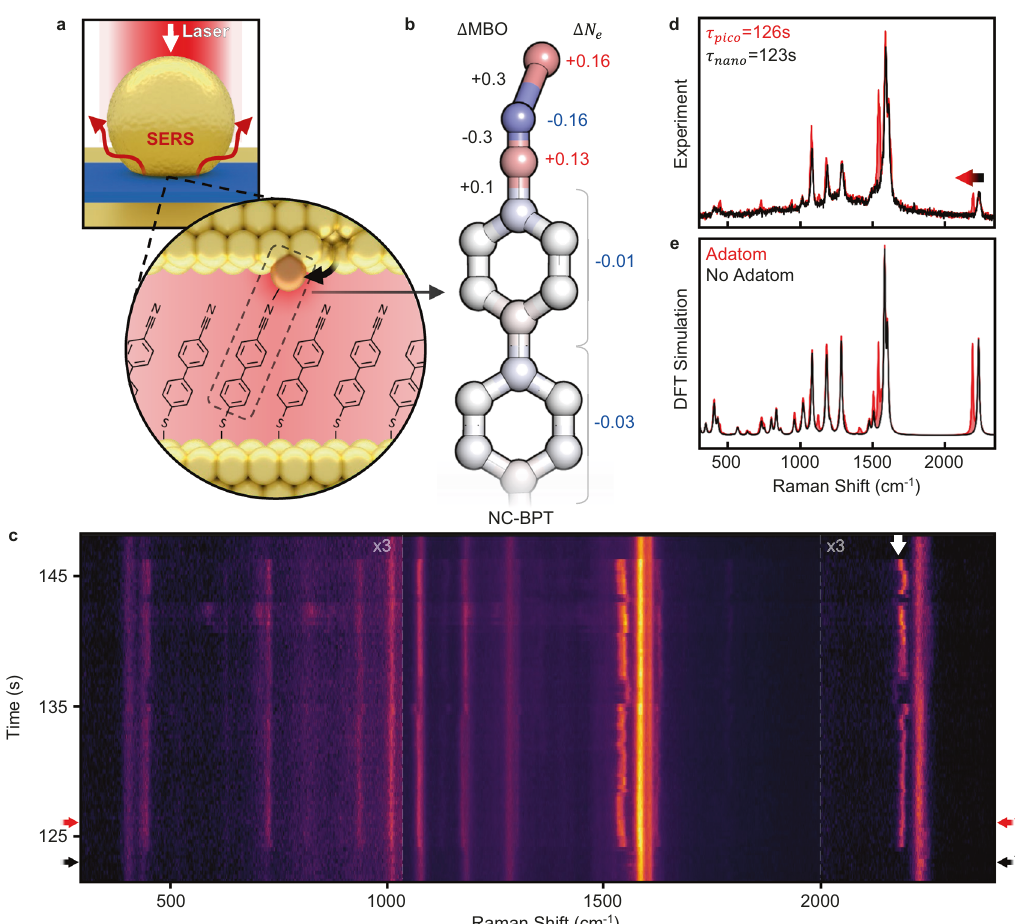
Fig. 1 Picocavity formation focuses light onto a single molecule. a Nanoparticle-on-mirror (NPoM) structure con fi nes light in nanocavity gap, further con fi ned by single gold adatom (inset) beside molecular monolayer of cyanobiphenyl-4-thiol (NC-BPT). b Changes in Mayer bond order (MBO) and charge density ( N e ) during energetically favourable interaction between Au adatom and C ≡ N bond. Red indicates an increase in charge density while blue indicates a decrease. c SERS spectra of NPoM system over time, including persistent nanocavity lines and transient picocavity lines perturbed by the single adatom (white arrow shows perturbed NC bond). τ nano and τ pico indicate times before and during the picocavity event shown in d single SERS spectra taken before ( τ nano ) and after ( τ pico ) the formation of a picocavity. e DFT spectra of the NC-BPT molecule with and without a gold atom positioned to reproduce experimental spectra, peak height scaled to experiment. Peak ratios without adatom are matched using optical polarisation direction. Peak ratios with adatom omit picocavity enhancement (see text) and thus ad hoc. Weaker C ≡ N mode in the experiment arises from lower optical collection ef fi ciencies at longer